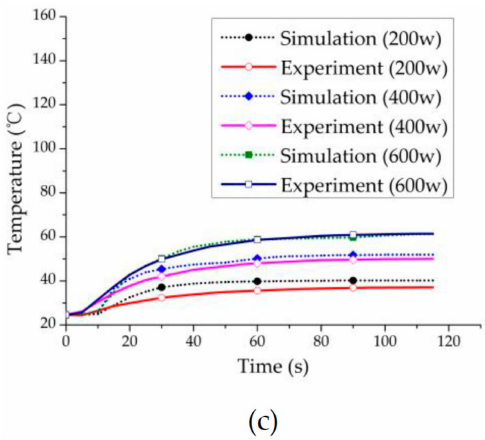
Figure 5. Temperature rise ( ◦ C) comparisons between the experiment and simulation: ( a ) temperature rise at a velocity of 60 mL/min; ( b ) temperature rise at a velocity of 120 mL/min; ( c ) temperature rise at a velocity of 180 mL/min.